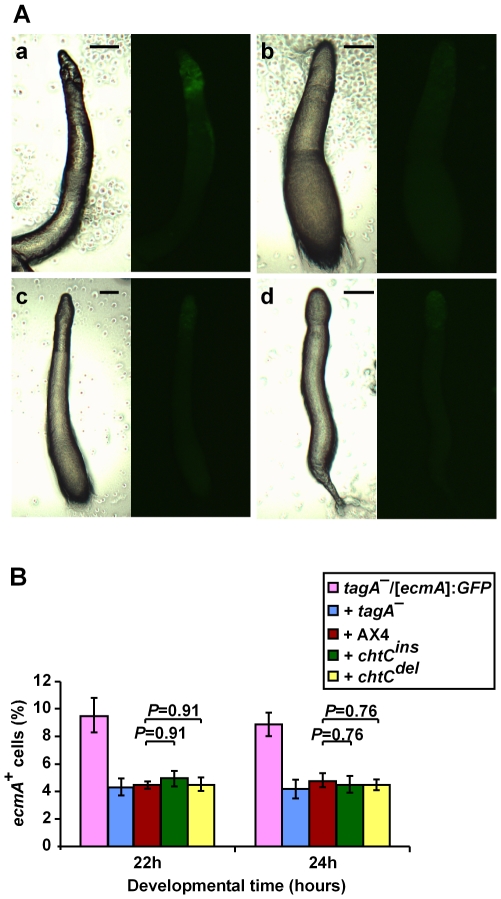
The tagA– mutant is unaffected by the presence of chtC mutants in chimerae.The strains were grown separately and mixed in the appropriate proportions before development in chimera. (A) We photographed multicellular structures after 16 hours of development under phase-contrast microscopy (left panels) and fluorescence microscopy (right panels). The tagA–/[ecmA]:GFP strain was mixed in a 1∶1 ratio with unlabeled tagA– cells (a), unlabeled AX4 cells (b), unlabeled chtCins cells (c), and unlabeled chtCdel cells (d). The entire prestalk region (shown by white arrows) is fluorescently labeled in a, but very little fluorescence in seen in b-d. Representative slugs for each chimeric mixture are shown. The scale bars represent 0.1 mm. (B) The tagA–/[ecmA]:GFP strain was developed either clonally or in a 1∶1 mix with unlabeled tagA–, AX4, chtCins, or chtCdel cells. We disaggregated the cells after 22 h and 24 h of development, and determined the proportion of GFP-positive cells by counting under the fluorescence microscope. The data are shown as the proportion (%) of fluorescent cells relative to the entire population. The results are the means and standard errors of 3 independent replications. The number of prestalk cells formed by the tagA– mutant is not significantly different in the presence of the chtC mutants, as compared to AX4 (Student's t-test). Individual P-values (corrected for multiple testing by the ‘Benjamini and Hochberg’ method) are indicated above the bars.